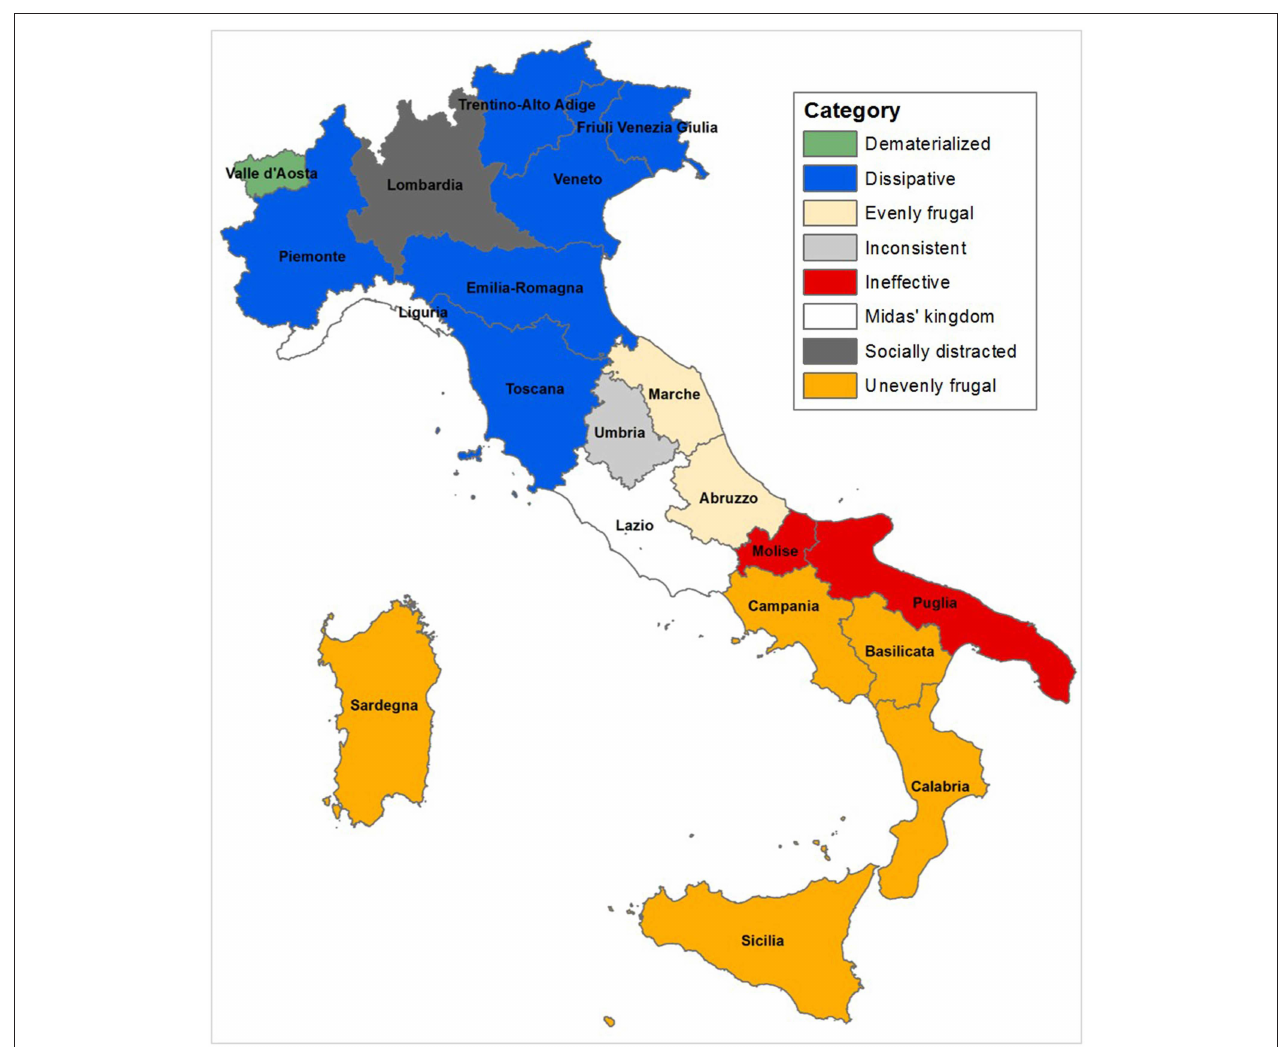
FIGURE 5 | Distribution of I-S-O categories in the national